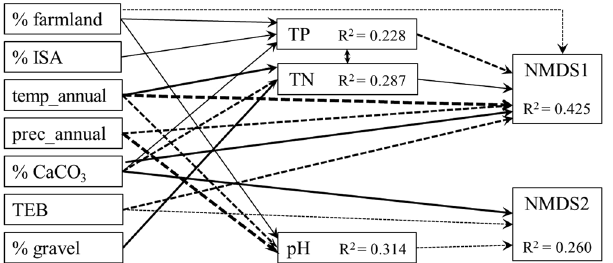
Figure 2. Structural equation modeling identifying significant pathways among human land use, natural environmental variables, in-stream stressors, and lotic benthic diatom species composition ( χ 2 = 0.350, RMSEA = 0.024, CFI = 0.993). Solid lines indicate positive standardized path coefficients (r), and dotted lines indicate negative ones. Thicker lines represent stronger relationships (—: |r| < 0.3; ─ : 0.3 ≤ |r| < 0.5; &#x25AC; : |r| ≥ 0.5). For the full names of each variable, please see Table 1.